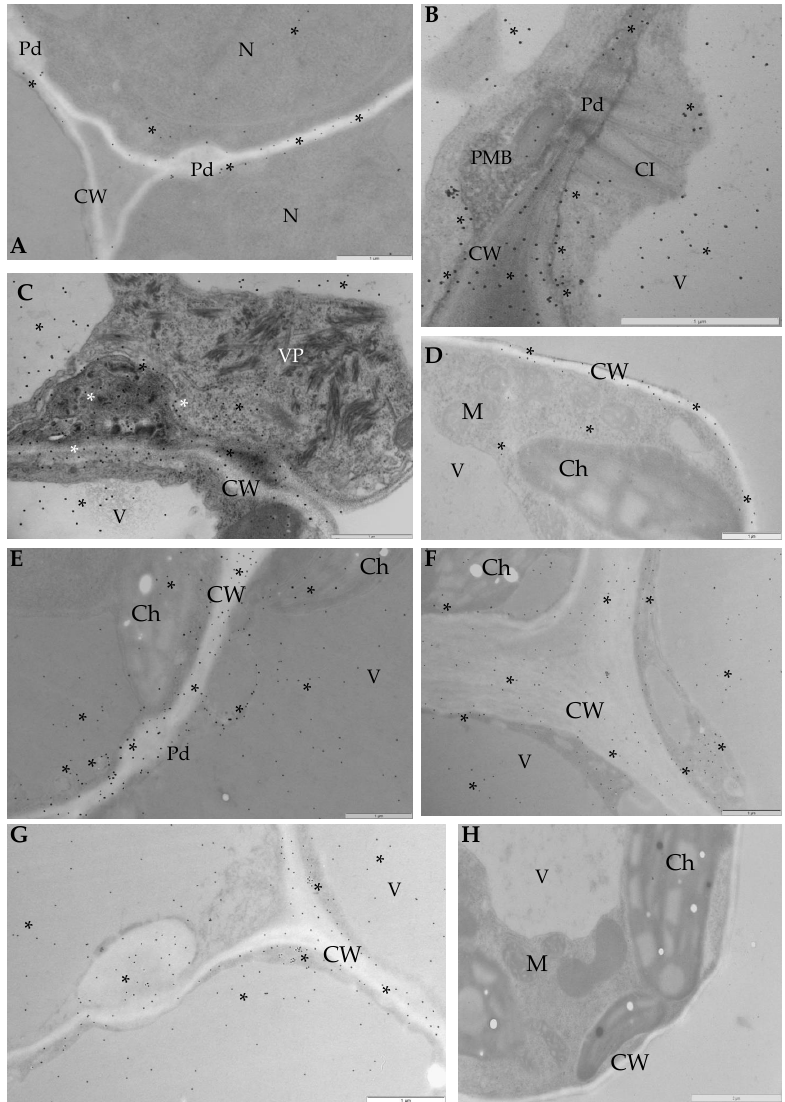
Figure 9. Immunogold localization of HGRP extensins in compatible ( B – C ) and incompatible ( E – G ) PVY NTN –potato interactions. ( A ) HRGPs (*) in mock-inoculated phloem cells in the cell wall, cytoplasm, and nucleus; bar 1 µ m ( B ) HRGPs (*) in the cell wall, plasmolemma, cytoplasm, and vacuoles in mesophyll cells at 14 days post-virus inoculation. Virus cytoplasmic inclusion next to plasmodesmata; bar 1 µ m. ( C ) HRGPs (*) in the changed cell wall, plasmolemma, vacuoles, and cytoplasm